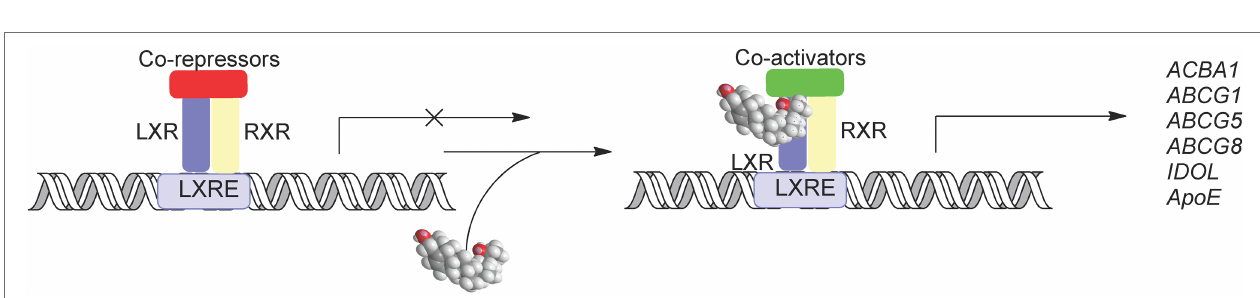
FIGURE 7 | Cartoon representation of the sterol-induced degradation of HMG-CoA reductase. Upper panel , 4,4-dimethyl sterols induce the binding of INSIG to HMG-CoA reductase (HMGCR). The E3 ubiquitin ligase gp78 and E2 ubiquitin-conjugating enzyme ubc7 ubiquitinate (Ub) HMG-CoA reductase. In a final step stimulated by geranylgeraniol, ubiquitinated HMG-CoA reductase is extracted from the membrane by VCP and delivered to the proteosome. Lower panel , 25-HC similarly induces degradation of HMG-CoA reductase, however, it has been suggested that sterol binding is to INSIG rather than the reductase (Goldstein et al., 2006).